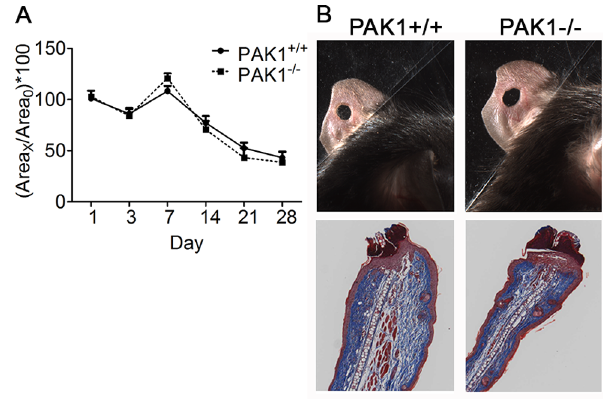
Figure 6. Unimpaired repair of cutaneous ear wounds in PAK1 2 / 2 mice. A) Recovery of 2.0 mm ear punch wounds is represented by (Area day X/ Area day 0 ) 6 100. There was a notably larger but not statistically significant wound diameter in PAK1 2 / 2 mice compared to PAK1 + / + mice on day 7. B) The wound edge was stained with Mason’s trichrome and shows a very similar wound closure between the two groups by day 28. n=3 for both PAK1 + / + and PAK1 2 / 2